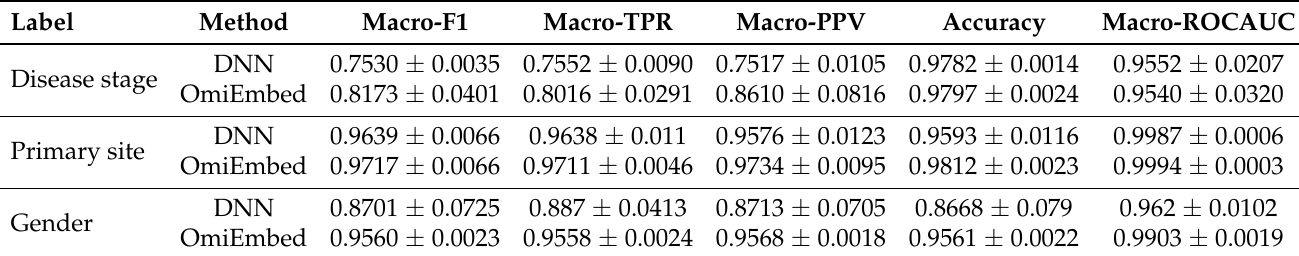
Table 5. The classification performance of predicting three categorical phenotype features on the GDC dataset.